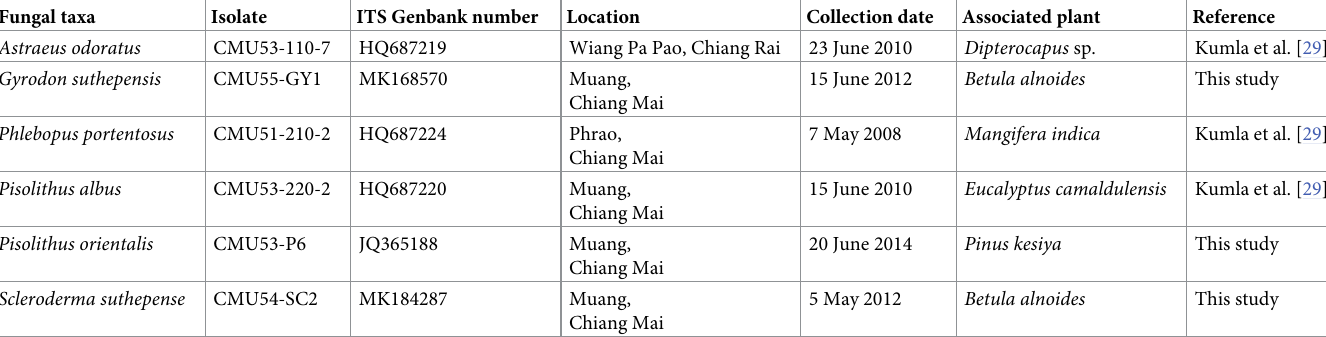
Table 1. Original, ITS GenBank accession number, collection date and host plant of fungi used in this study. Fungal